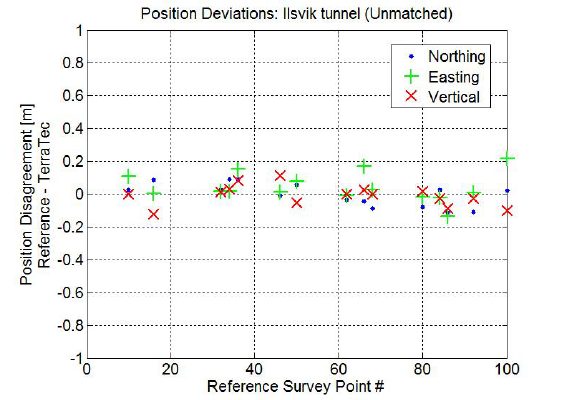
Figure 7: TerraTec system solution deviations relative to the refer- ence measurements when matching is not utilized, Ilsvik tunnel.